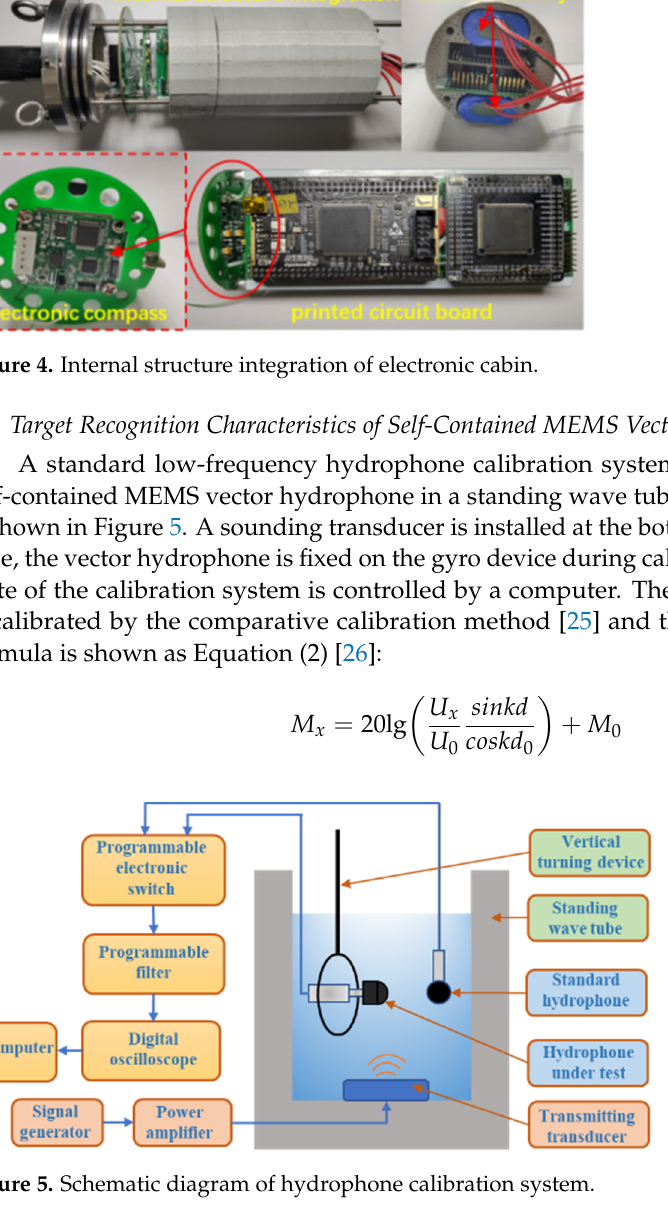
( b ) Figure 6. Sensitivity curve of sensor. ( a ) Vector channel; ( b ) scalar channel.